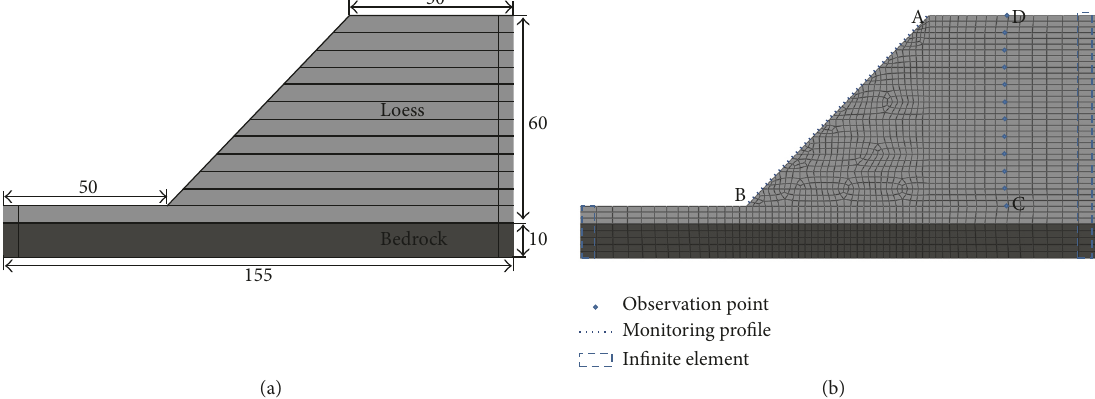
Figure 7: Models of finite element analysis. (a) Profile of the loess slope (unit: m); (b) Finite element model.